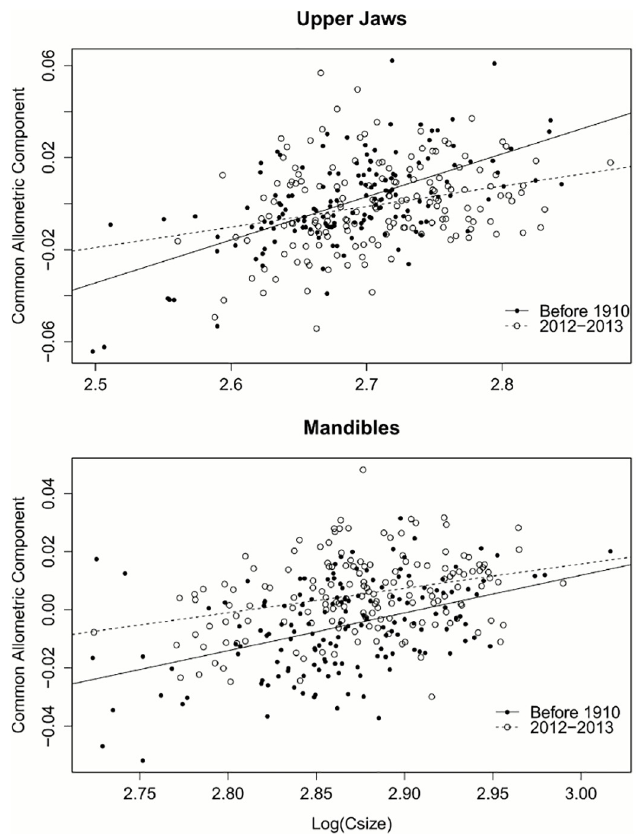
Fig 4. Allometry of upper jaws and mandibles by time period. Prediction lines represent a regression of shape values (common allometric component) within time period on the log of the centroid size [Log(Csize)], based on 150 historic and 160 contemporary specimens. Allometry tests show significant effects of size and year on shape for both structures. Interaction of size:period is significant for upper jaws, but not mandibles. Regression lines are historic upper jaws: CAC = 0.1876 * Csize-0.5037; contemporary upper jaws: CAC = 0.08492 * log(Csize)- 0.23; historic mandibles: CAC = 0.134 * log(Csize) – 0.3886; contemporary mandibles: CAC = 0.1005 * log(Csize) –